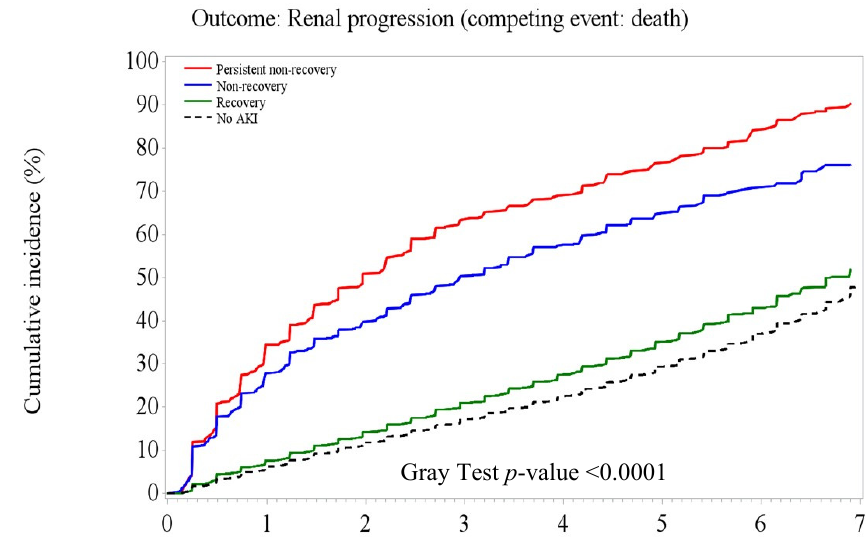
Figure 5. Among patients with prior chronic kidney disease (CKD; n = 16,149), the Kaplan–Meier plot shows that the highest risk for composite adverse kidney outcomes was in the PNR- and NR-AKI groups, and the risk was close between the recovery AKI and no-AKI groups. Adverse kidney outcomes: eGFR declined > 30% baseline or <15 mL/min/1.73 m 2 , kidney-replacement therapy.